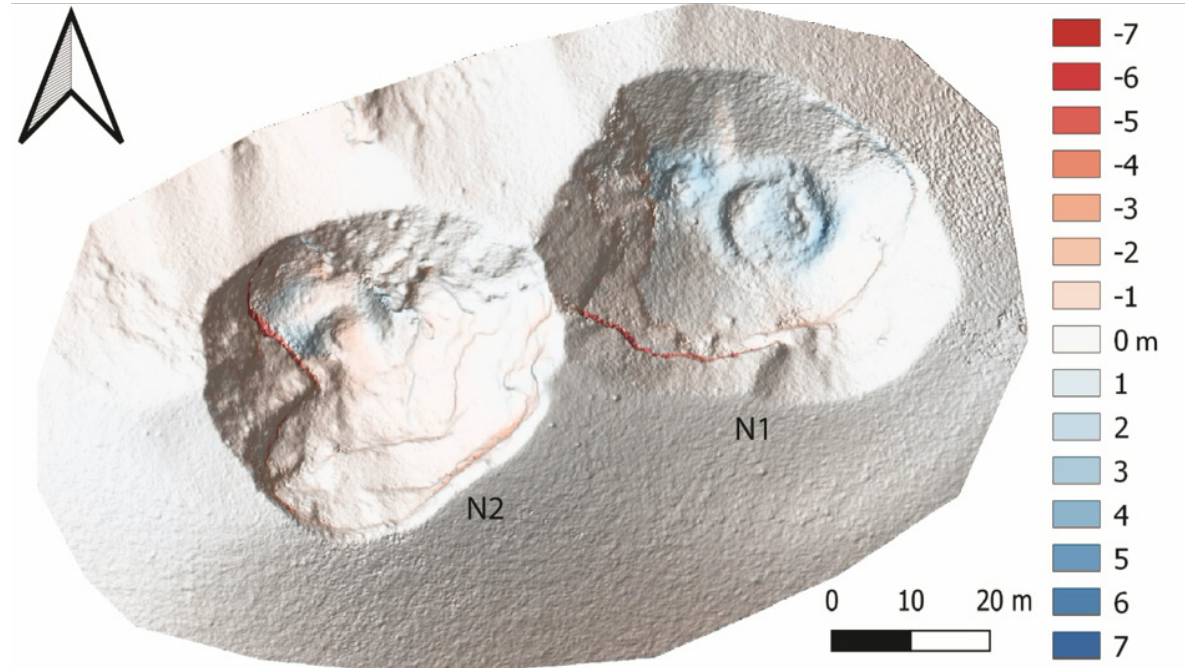
Figure 5: Topographic changes in N1 and N2 between June 8 and 12. Within this 4 day interval retrograde erosion altered the western wall of N2 and the south-western wall of N1 (dark red lines). Elevation gain is strongest within N1 visible as two circular features on the crater floor. Arrow indicates North. Each colour of the colour key spans ˘ 0.5 m around the labelled